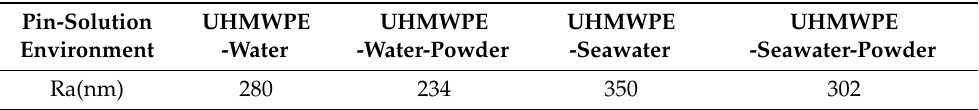
Figure 4. Micrograph images captured using white-light interference three-dimensional profilometer. Table 4. The roughness of the UHMWPE pin